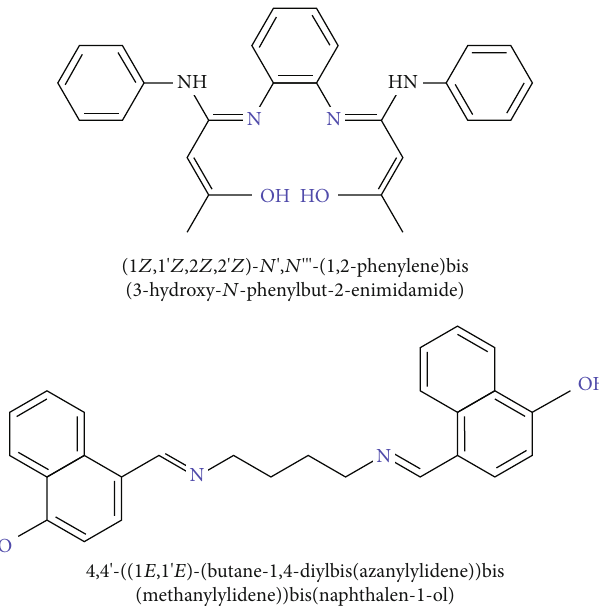
Figure 1: Representation of the ionophore molecules developed by Gupta et al. [44]. Proposed groups responsible for cation sorption are presented in blue.